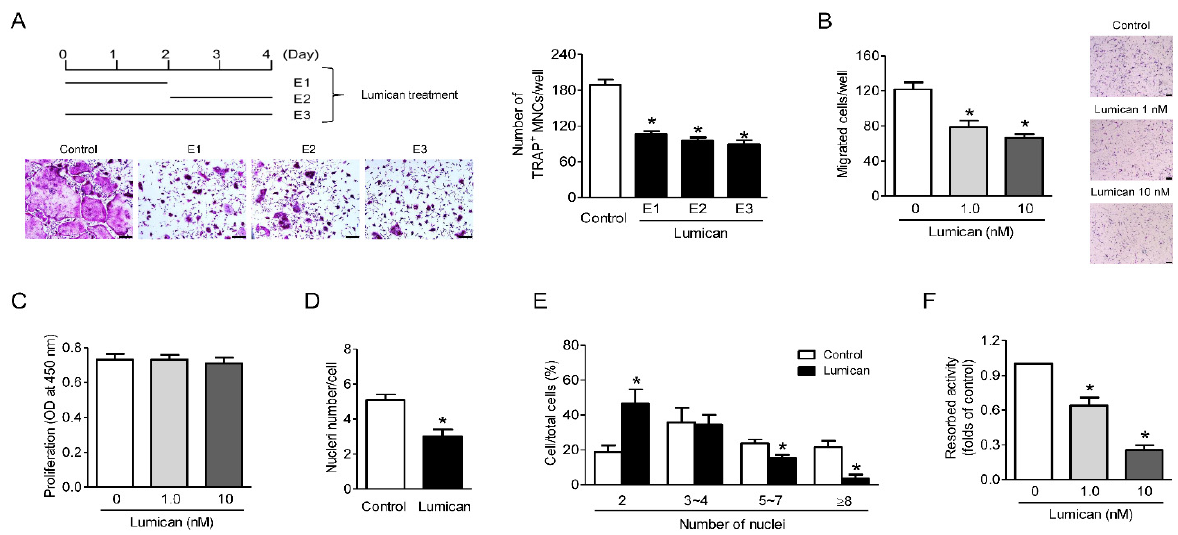
Figure 2. Lumican inhibits bone resorptive activity as well as migration and fusion of preosteoclasts. ( A ) Primary mouse BMMs were exposed to 10 nM lumican on the first 2 days (E1), last 2 days (E2), or entire 4 days (E3) of a 4-day culture in the presence of 30 ng/mL RANKL and 30 ng/mL M-CSF. After the cells were stained with TRAP, the number of TRAP-positive multinucleated cells (MNCs) ( ≥ 3 nuclei/cell) was determined to assess osteoclast differentiation ( n = 3). ( B ) Mouse BMMs were incubated with 30 ng/mL M-CSF for 3 days, and then directional migration was assessed through a Boyden chamber system after treatment with 1 nM or 10 nM lumican for an additional 6 h ( n = 5). ( C ) Mouse BMMs were cultured with 30 ng/mL M-CSF for 3 days, and then proliferation was assessed by BrdU assay after treatment with 1 or 10 nM lumican for an additional 1 day ( n = 5). ( D , E ) TRAP staining of mouse BMMs was performed after treatment for 3 days with 30 ng/mL RANKL and 30 ng/mL M-CSF in the presence of 10 nM lumican ( n = 3). ( D ) Nuclei per TRAP-positive cell. ( E ) Percentages of cells with the indicated numbers of nuclei. ( F ) After full differentiation of primary osteoclast precursors into osteoclasts by incubation for 3 days with 30 ng/mL RANKL and 30 ng/mL M-CSF, cells were seeded on dentine discs and cultured for an additional 3 days in the presence of 1 or 10 nM lumican with RANKL and M-CSF. Resorption pits were visualized by hematoxylin staining ( n = 3). Scale bars: 100 μ m ( A ) and 50 μ m ( B ). Data are means ± SEM. * p < 0.05 vs. untreated control.